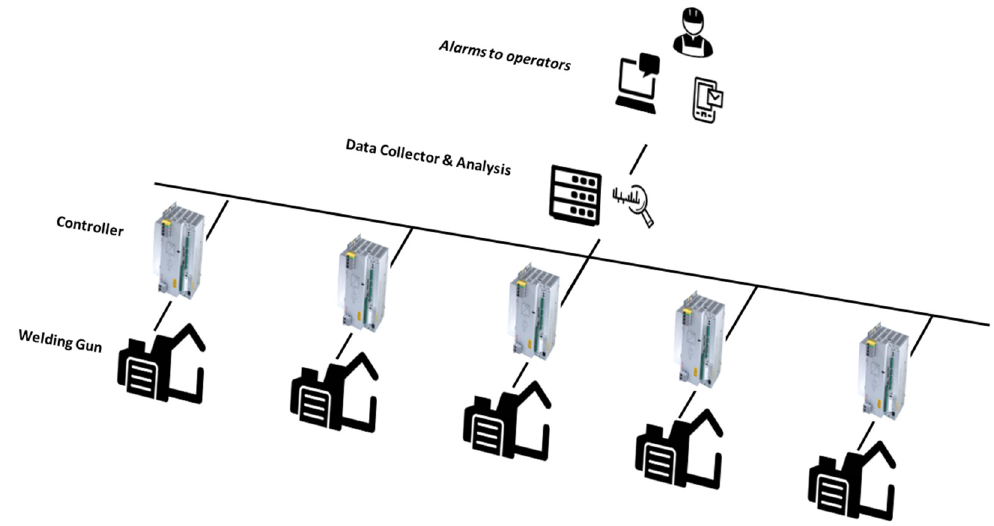
Figure 11. Real-time data collection schema.